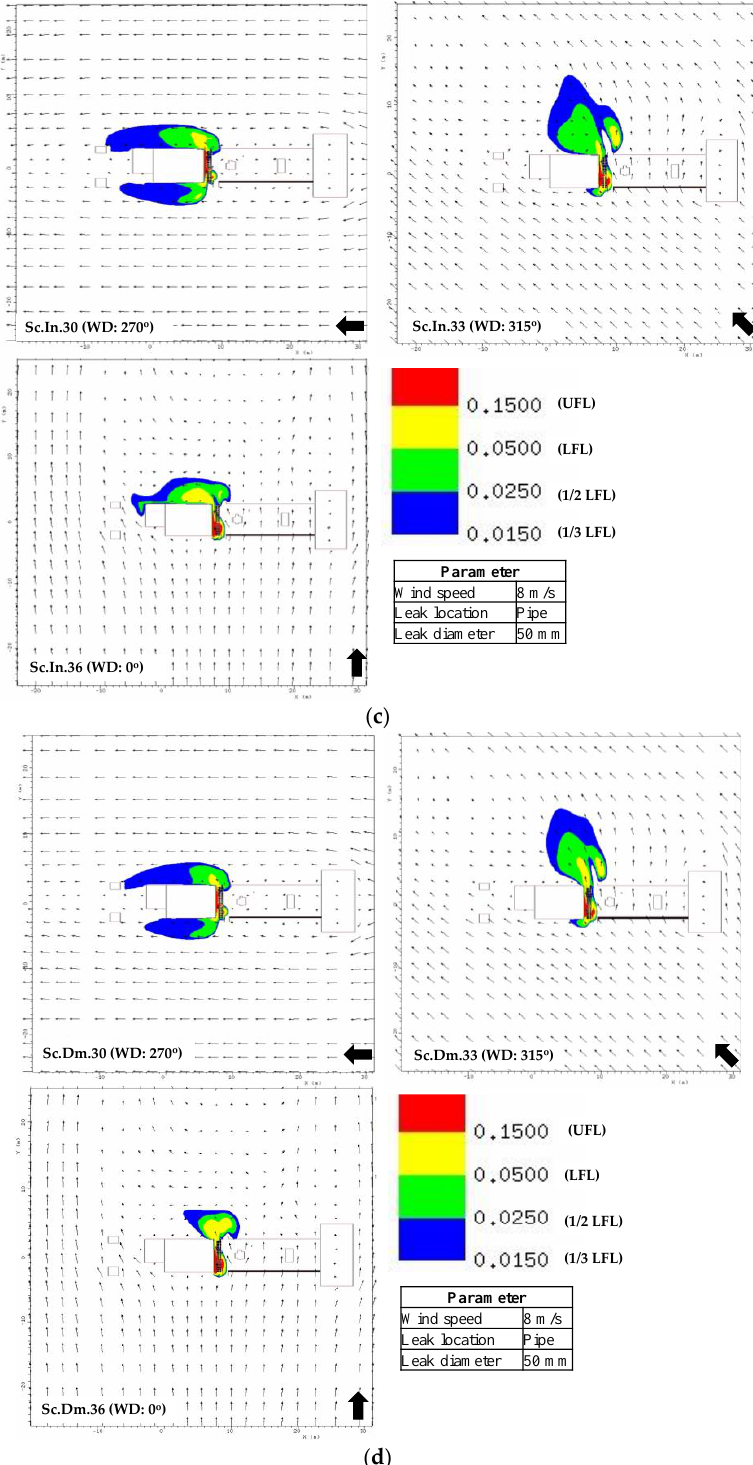
Figure 14. Gas contour plot for the 50 mm pipe leak at ( a , b ) 2 m/s and ( c , d ) 8 m/s wind speed.